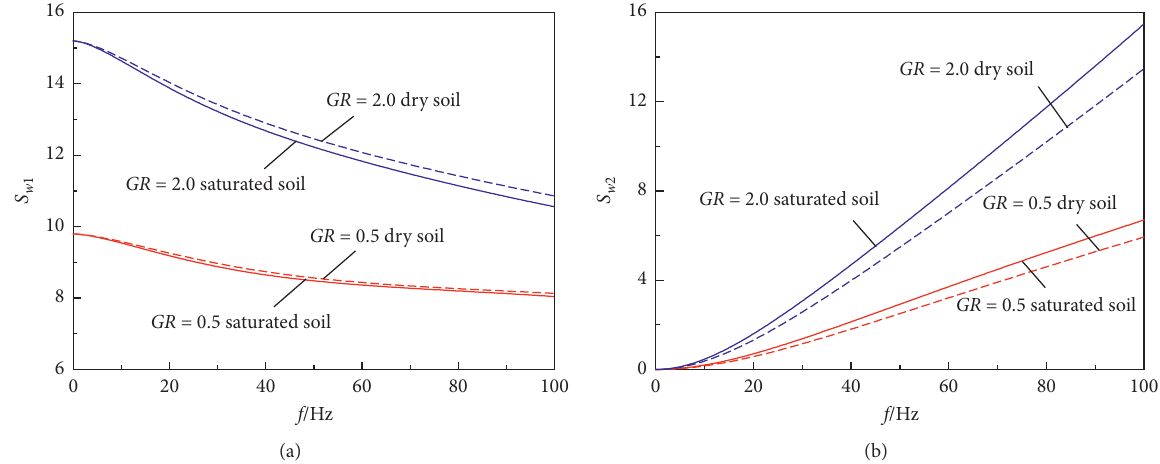
Figure 4: Comparison of torsional impedance of saturated soil solution with the reduced dry soil solution for a radially inhomogeneous soil ( D sm � D s 0 � 0, t m / r 0 � 0.5, r 0 �